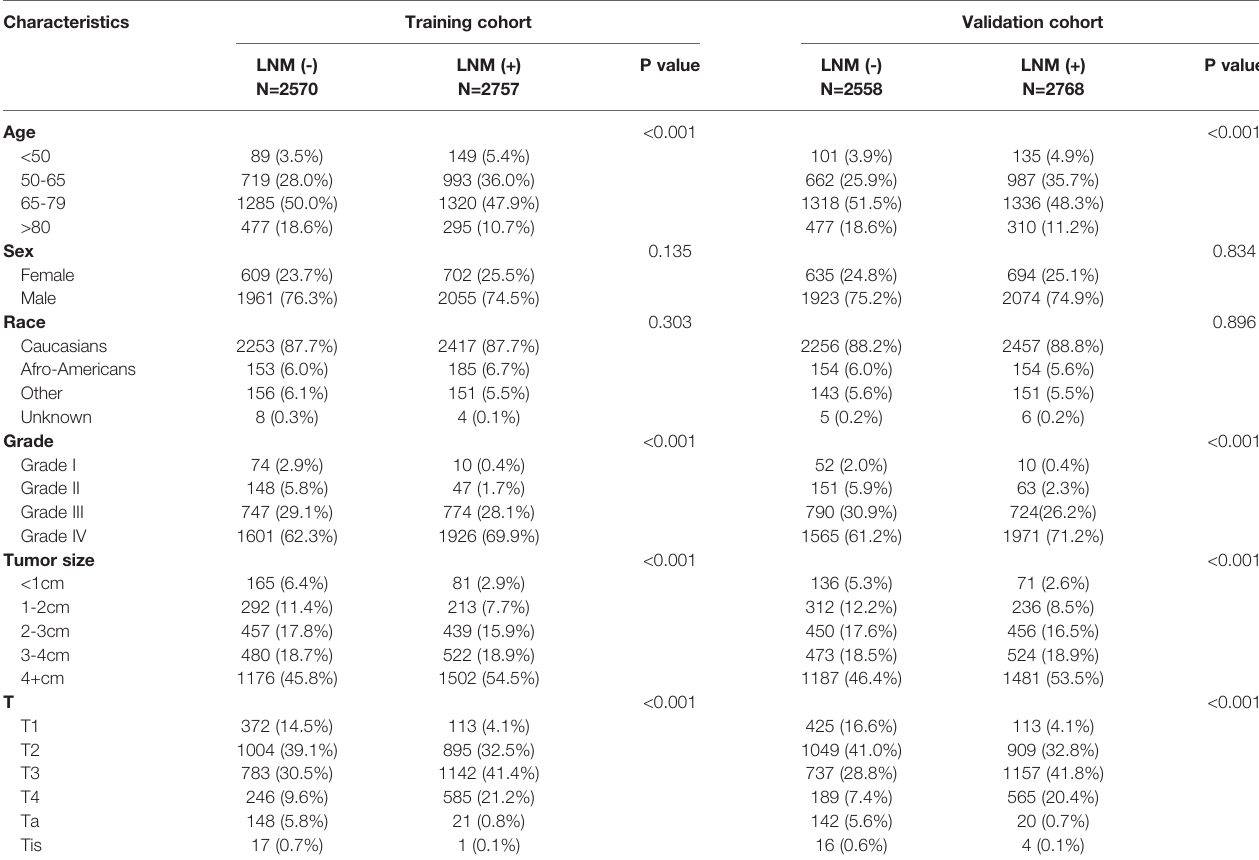
TABLE 1 | Clinicopathological characteristics of the cohort by lymph node status.